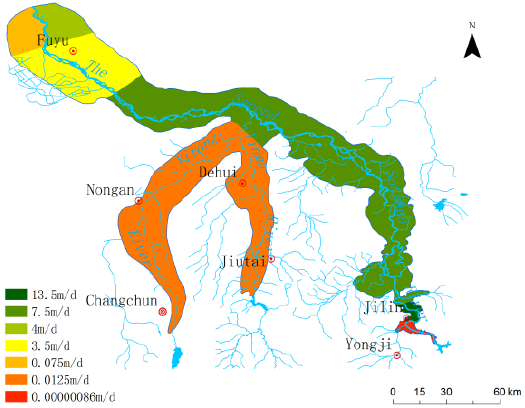
Water 2016 , 8 , 176 Figure 17. Illustration of the No. 3 hydrogeology profile. Figure 17. Illustration of the No. 3 hydrogeology profile.